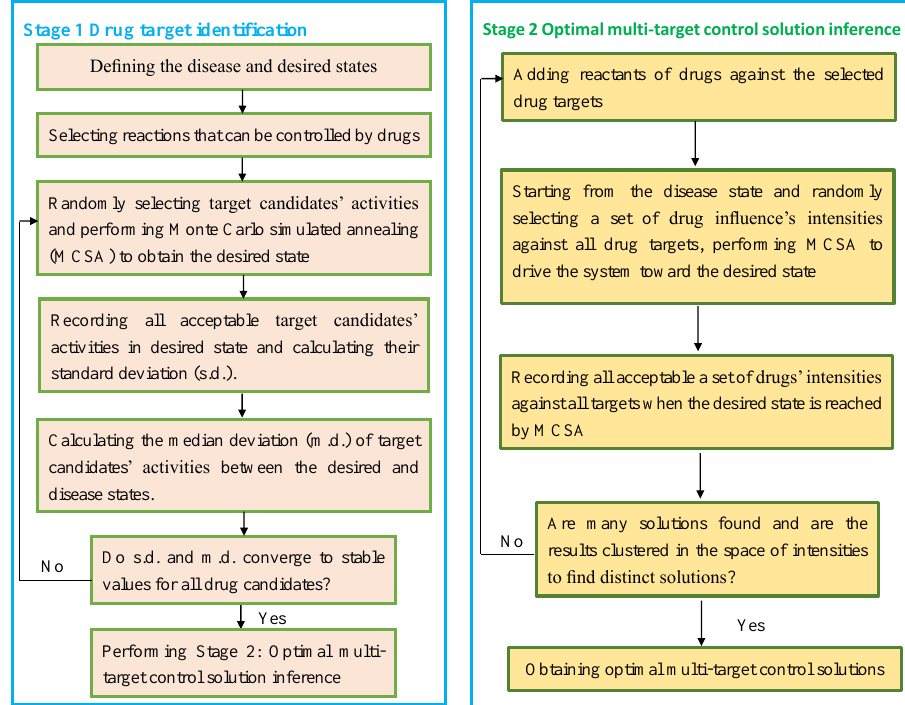
Figure 2. The flowchart of multiple target optimal intervention solutions